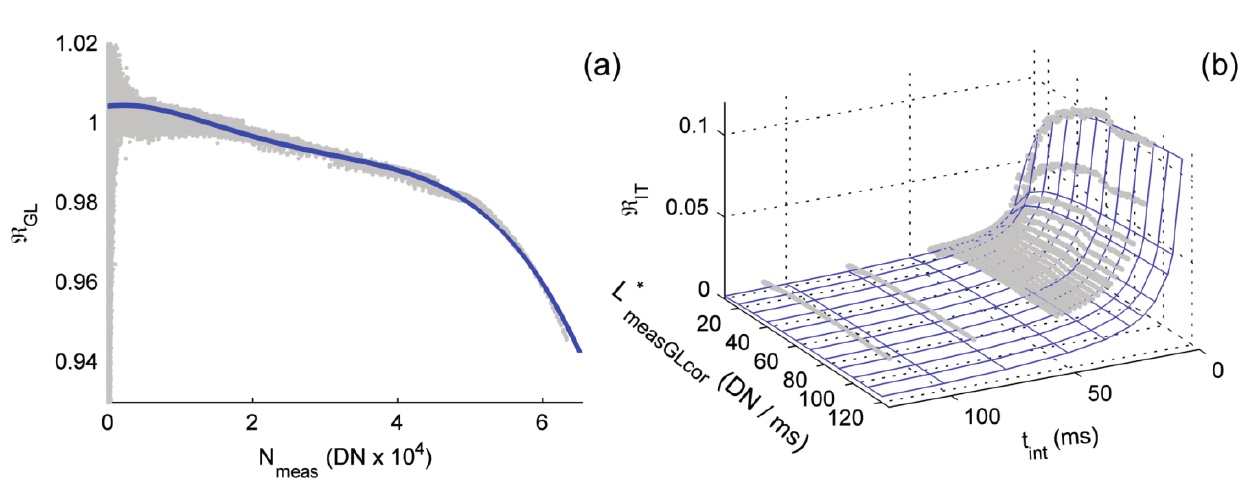
Figure 2. Channel 1’s non-linearity models: ( a ) NL model related with the gray level ( ℜ GL ); ( b ) NL model related with the integration time ( ℜ IT